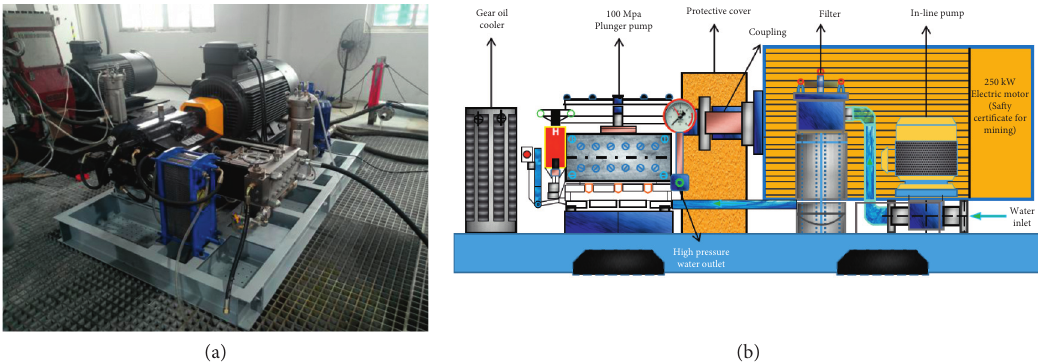
Figure 8: Assembly drawing of high-pressure water pump. (a) Real picture of equipment. (b) Function diagram of each part of equipment.